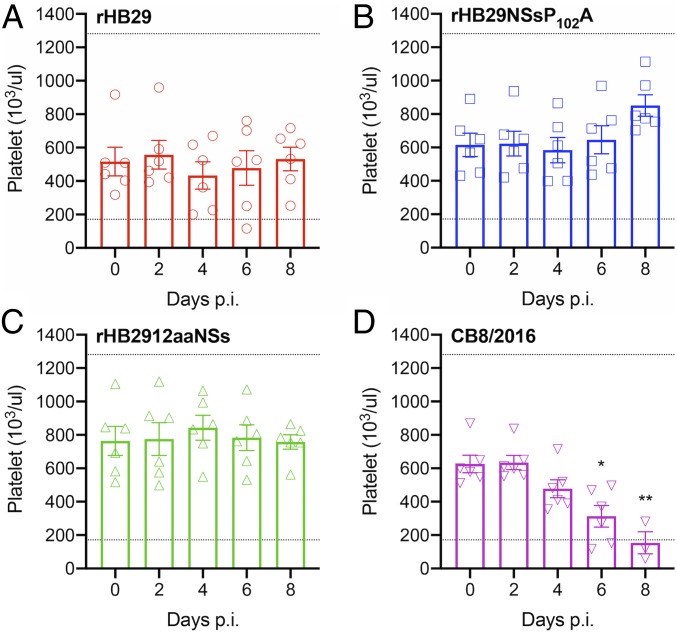
Hematological analysis of platelets in SFTSV-inoculated ferrets. Blood from infected ferrets was collected every other day, and hematological examination was performed using a Celltac hematology analyzer. Platelet counts from rHB29 (A), rHB29NSsP102A (B), rHB2912aaNSs (C), or CB8/2016 (D) are shown. Normal ranges of platelet counts in ferrets are 171.7 to 1,280.6 × 103/µL and 2.5 to 16.7 × 106/µL, respectively (46, 58). The dashed lines indicate the normal values of platelet counts. The asterisks indicate significance compared to each day p.i. sample by one-way ANOVA with Dunnett multiple comparison test. *P = 0.0404 (A) and *P = 0.0016 and **P = 0.0002 (D). Each experiment was performed for 3 biological and 3 technical repeats.